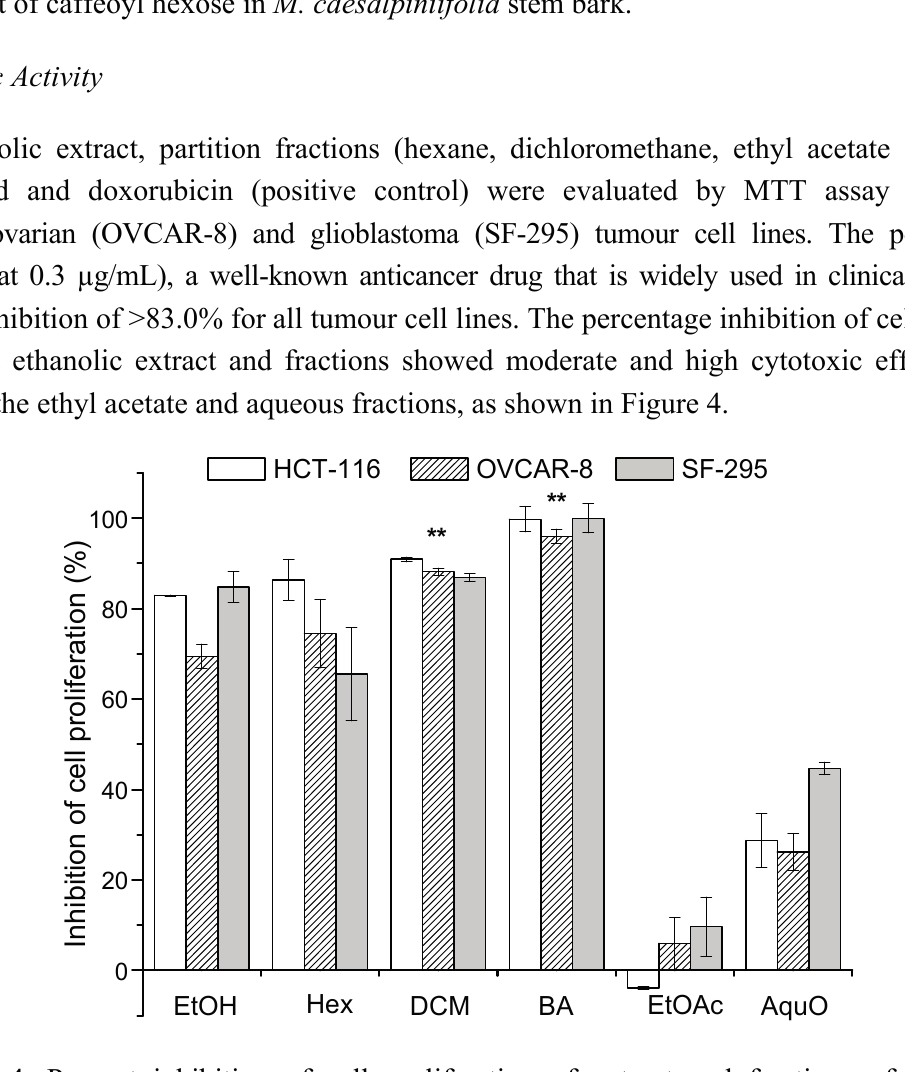
Figure 4. Percent inhibition of cell proliferation of extract and fractions of Mimosa caesalpiniifolia stem bark on cancer cell lines. HCT-116 (colon carcinoma), OVCAR-8 (ovarian carcinoma) and SF-295 (glioblastoma). EtOH (ethanolic extract), Hex (hexane fraction), DCM (dichloromethane fraction), BA (betulinic acid, isolated from hexane fraction), EtOAc (ethyl acetate fraction) and AquO (aqueous fraction). Asterisks ( ** ) indicate no significant differences ( p > 0.05, one-way